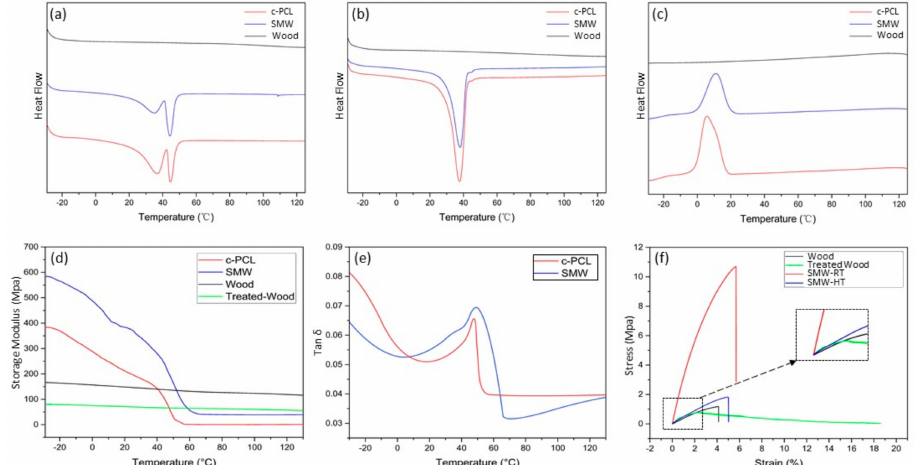
Figure 7. DSC curves of c-PCL, SMW, and wood: ( a ) First heating stage; ( b ) second heating stage; ( c ) cooling stage; DMA curves of c-PCL, SMW, wood, and treated-wood; ( d ) storage modulus; ( e ) tan δ curves of c-PCL and SMW; ( f ) tensile stress-strain curves of wood, treated-wood, SMW-RT (room temperature), and SMW-HT (temperature 65 ◦